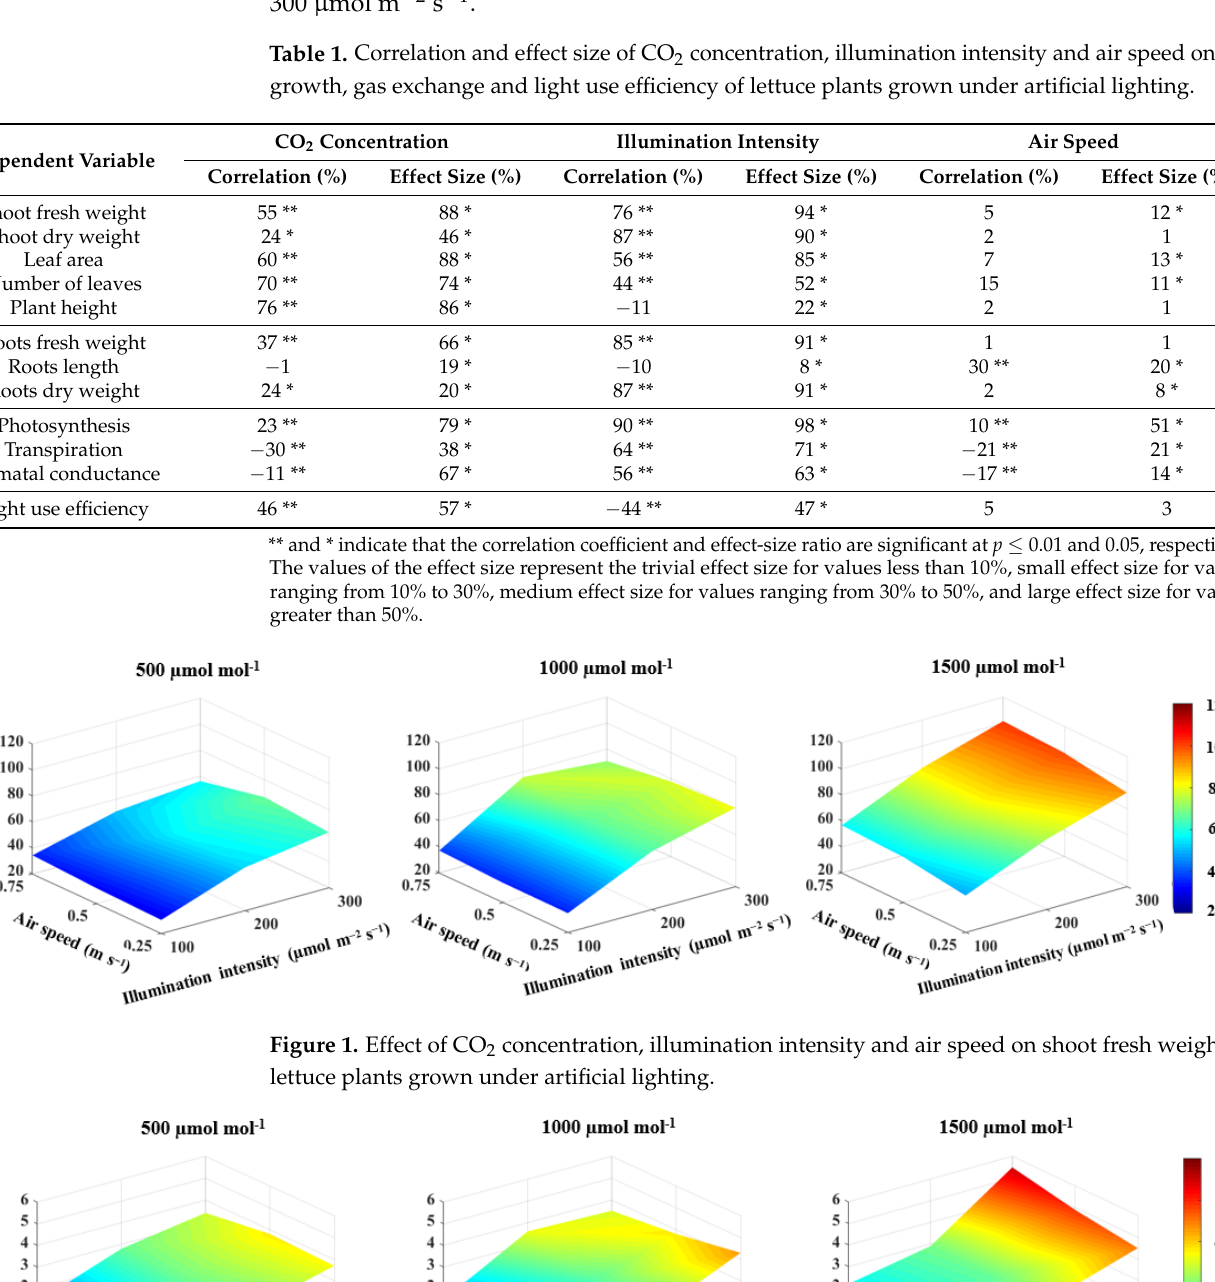
Table 1. Correlation and effect size of CO 2 concentration, illumination intensity and air speed on the growth, gas exchange and light use efficiency of lettuce plants grown under artificial lighting.